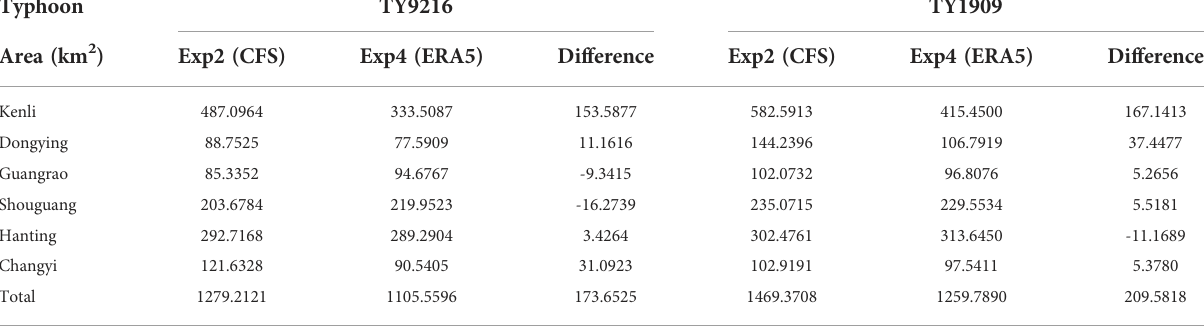
TABLE 7 The inundation areas and their differences between CFS- (Exp2) and ERA5-based (Exp4) simulations along the LZB during TY9216 and TY1909.